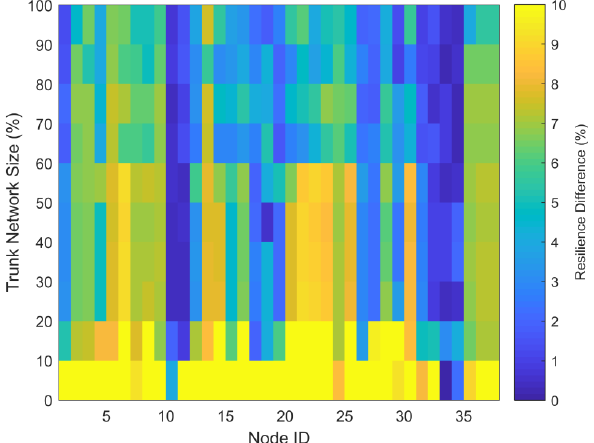
Figure 10. Resilience reduction according to TN size and the location of a pipe burst.